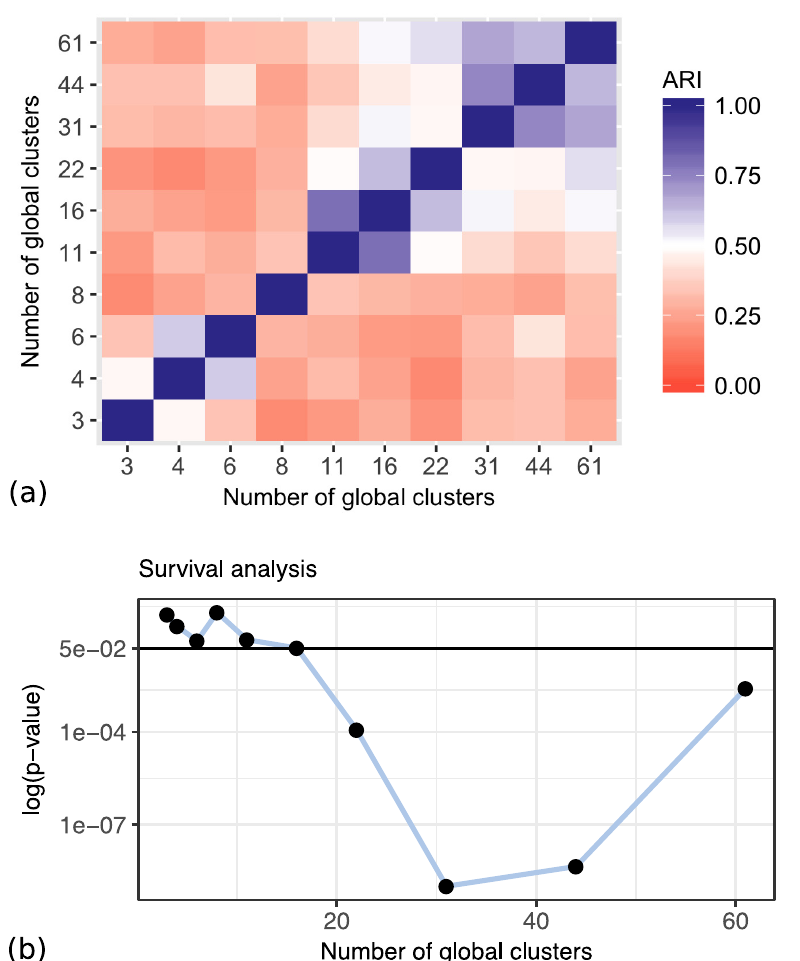
Fig 19. Consistency of results and survival p -values for clusters identified in the kidney cancer dataset, with a range of numbers of global clusters and 3 local clusters. (a) Consistency of results with respect to the ARI betweendifferent settings of numbers of globalclusters. (b) p -values corresponding to the different numbers of globalclusters. K ( c ) is a fixed parameter for the maximum number of clusters in dataset c and z ð c Þ cator variable which defines the cluster assignment of sample x ð c Þ probability of a sample belonging to a cluster k in context c is p ð c Þ